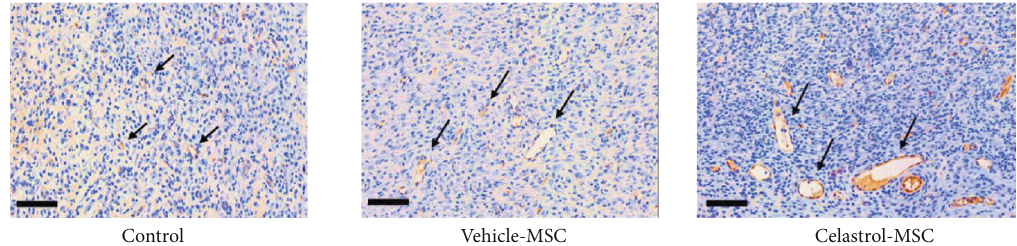
Figure 8: Representative images showing the increase of neovessel density with MSC in the peri-implant region (granulation tissue). Celastrol-treated MSCs display the highest neovessel density. Arrows indicate neovessels following vWF staining (brown); scale bar 100 μ